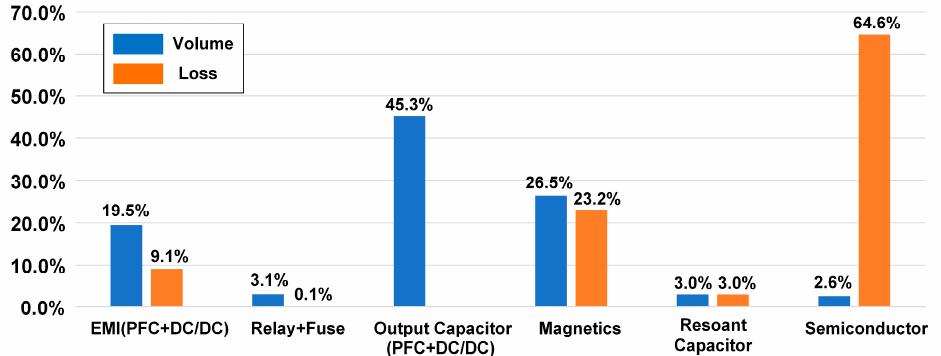
Figure 5. Volume and power loss distribution of 3.3 kW prototype. Table 2. Designed parameters of 3.3 kW full-bridge (FB) LLC resonant